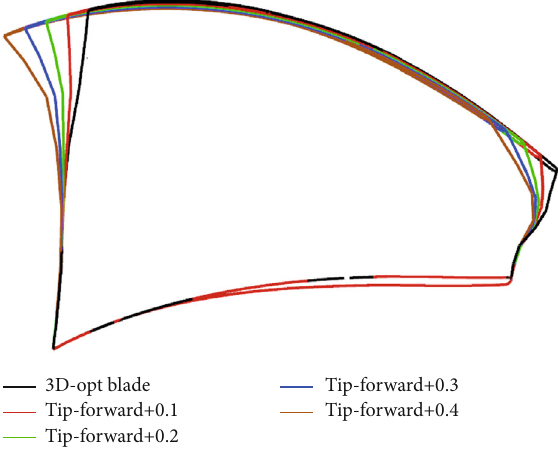
Figure 19: Shapes of rotor blades. Table 7: Performance of fi ve rotors with di ff erent forward sweeps of the blade